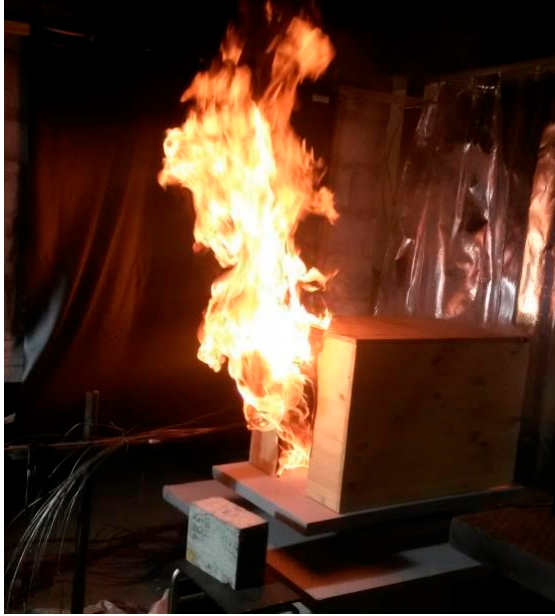
Figure 5. Small scale (1/4) pine wood (5.1 wt % FMC) compartment fire just post flashover